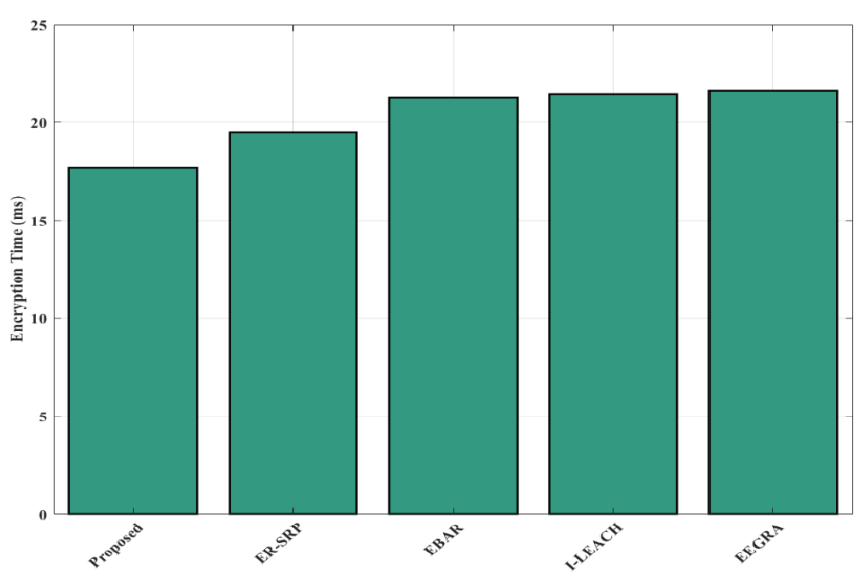
Figure 16. Comparison on the decryption time.